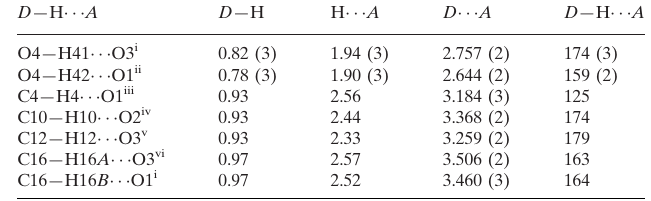
Hydrogen-bond geometry (A˚ , (cid:2)